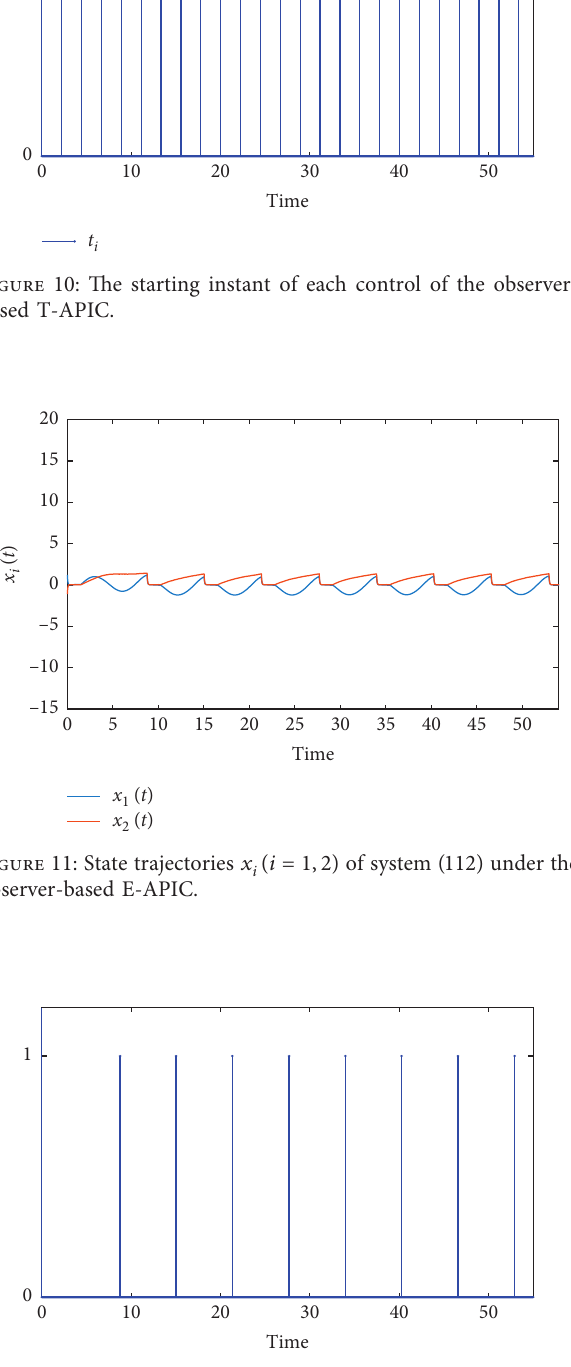
Figure 9: State trajectories x observer-based T-APIC.